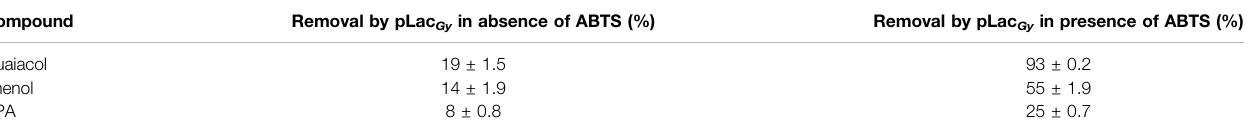
TABLE 2| AbilityofpLac Gy toremove phenolic pollutants inabsenceand presence ofABTSasaredox mediator. Assaymixture included 1µM pLac Gy ,1 mMABTS, 50 µM